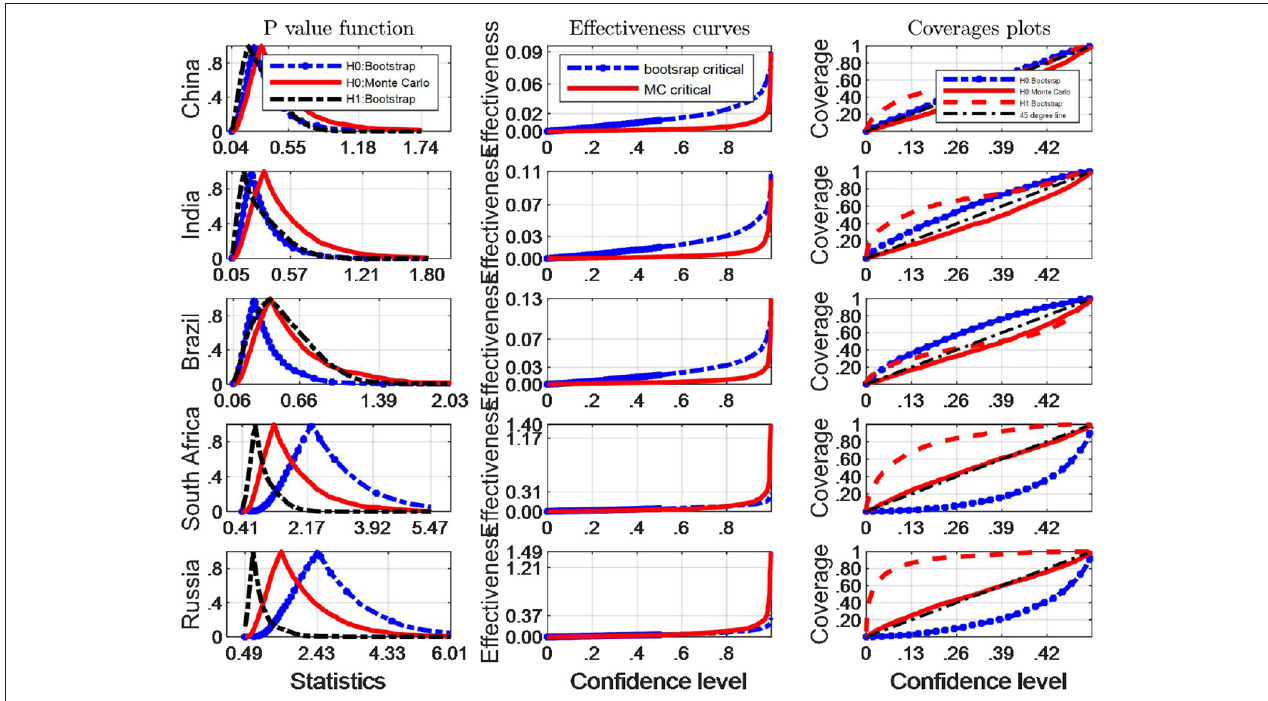
FIGURE 5 | A comparison of confidence intervals of Monte Carlo and counterparts of bootstrap for the Mayoral test using EF